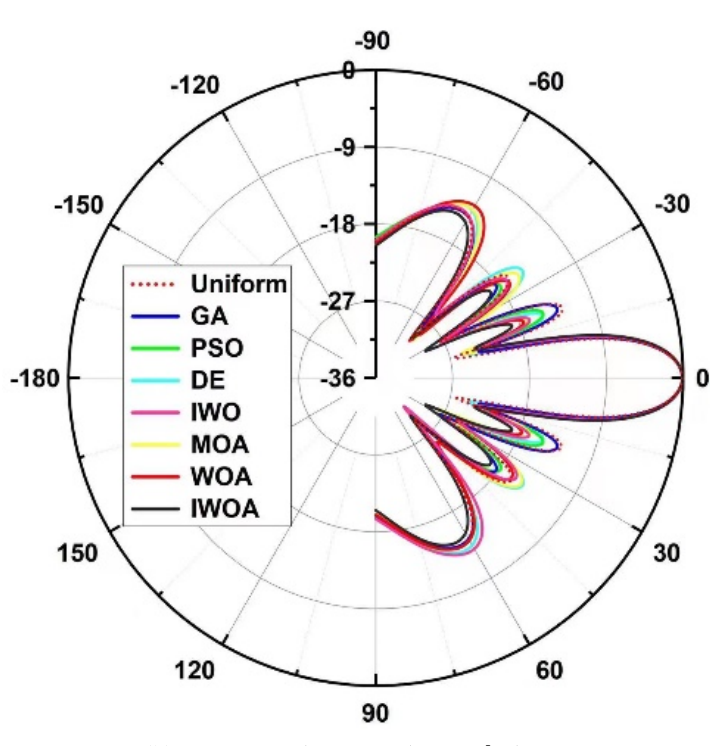
Figure 14. The 2D EM simulation